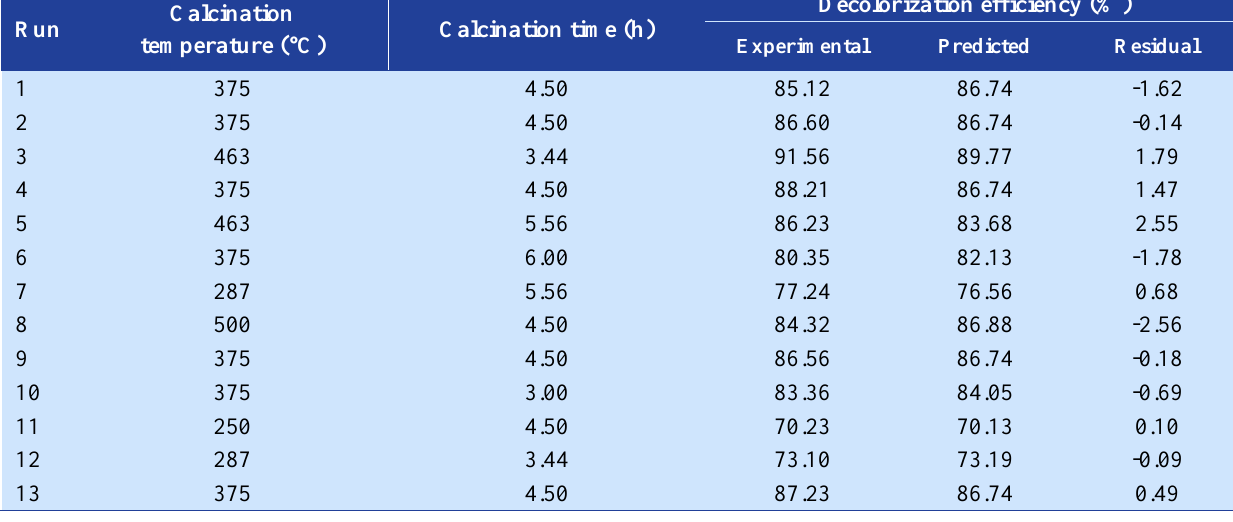
Table 2. Experimental and predicted results of applied central composite design (CCD)